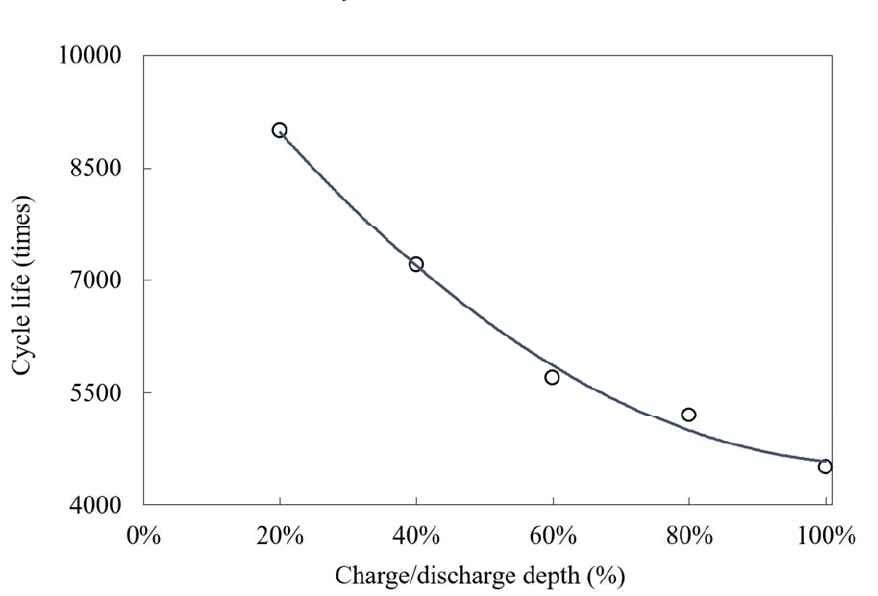
Figure 5. Depth of charge/discharge versus the cycle life of the Lithium-ion